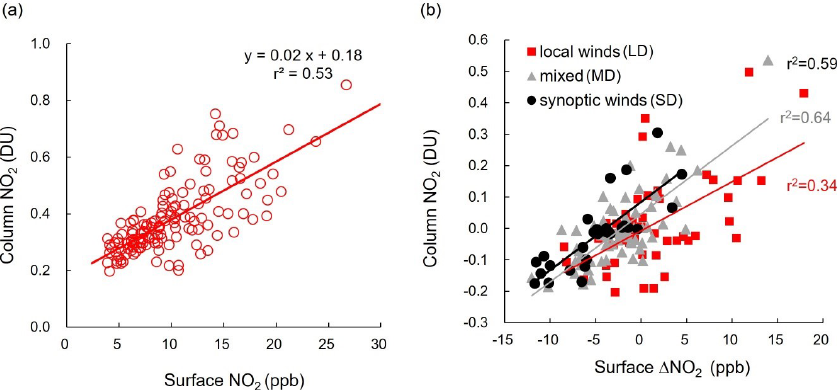
Figure 5. (a) Scatterplots of daytime measurements at site PA 4 (a) PC-NO 2 vs. SI-NO 2 under all meteorological conditions and (b) PC- NO 2 vs. surface NO 2 in each meteorological condition over a 1-year period (12 November 2020–30 October 2021). Here surface NO 2 = SI- NO 2 − (30d moving average) SI-NO 2